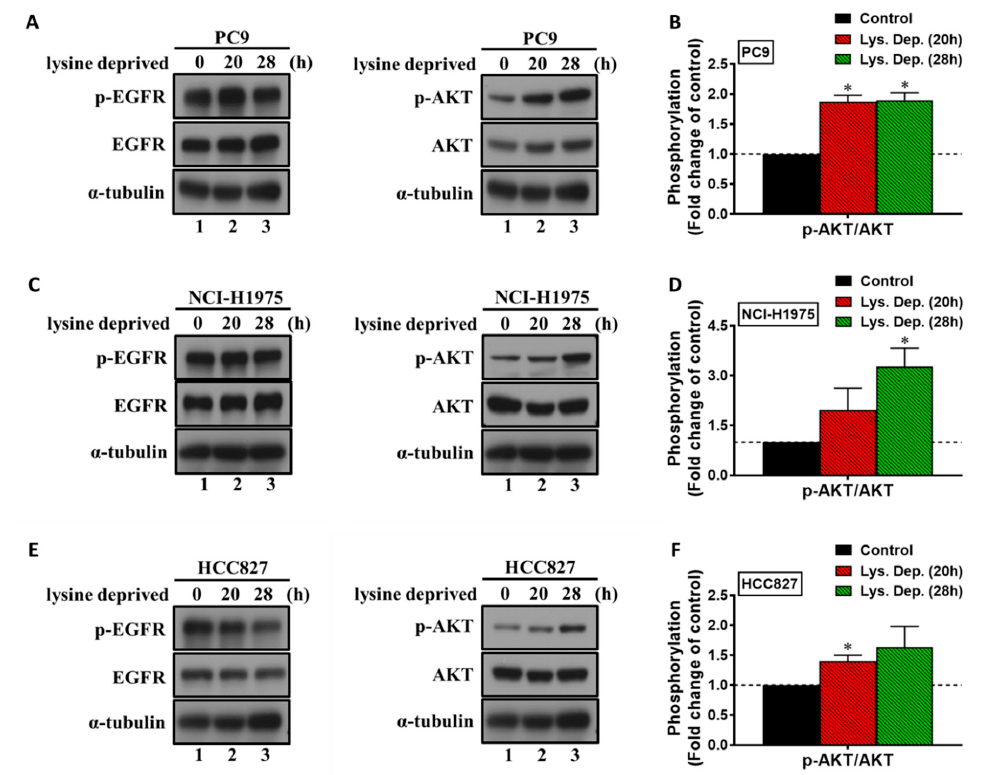
Figure 5. Lysine deprivation induces the phosphorylation of EGFR downstream targets. ( A , B ) PC9, ( C , D ) NCI-H1975, and ( E , F ) HCC827 cells were incubated with lysine-deprived RPMI for 20 and 28 h, and whole-cell extracts were used for Western blot analysis with antibodies against phosphor-EGFR (p-EGFR), EGFR, phosphor-AKT (p-AKT), AKT, and α - tubulin. Western blot analysis of each relative fold change was measured using the ImageJ software, normalized to each control group. The results shown are representative of three independent experiments. The data are presented as the mean ± SEM (*, p < 0.05 compared with the control group). Lys. Dep., lysine deprivation. Uncropped Western Blots can be found in Figures S7 and S8.